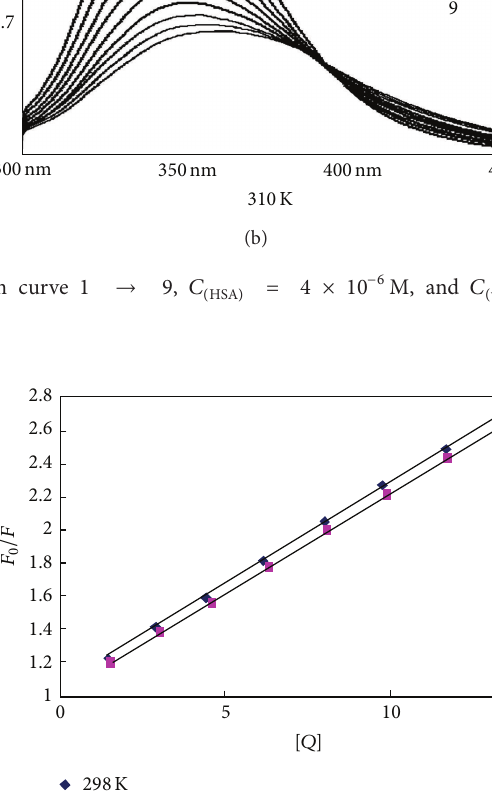
Figure 4: Synchronous fluorescence of effect of absence and = 4 × 10 −6 M, presence of ferulic acid on HSA-warfarin, 𝐶 ( HSA ) 𝐶 = 2 × 10 −8 M, and 𝐶 = 3 × 10 −8 M. Figure 5: Stern-Volmer plots of warfarin-HSA at different temper- ( warfarin ) ( ferulicacid ) atures.